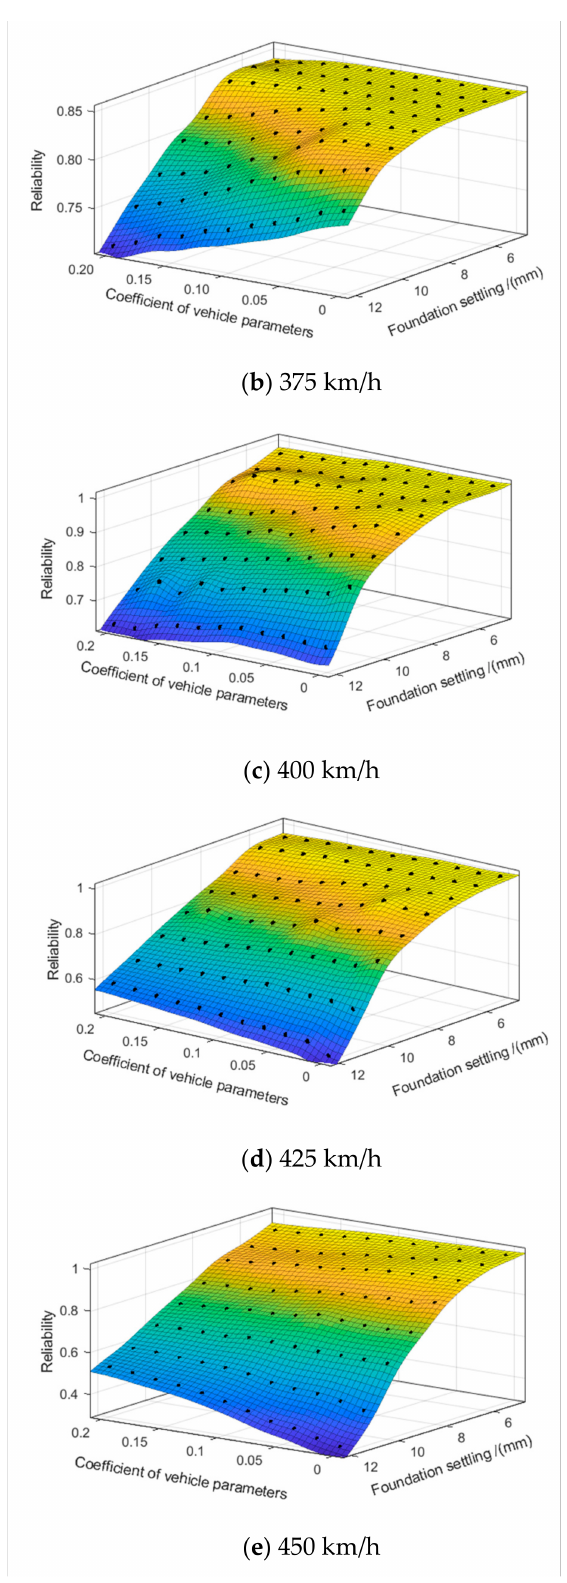
Figure 17. Reliability of vehicle vertical safety with different deformation amplitudes and differ- ent